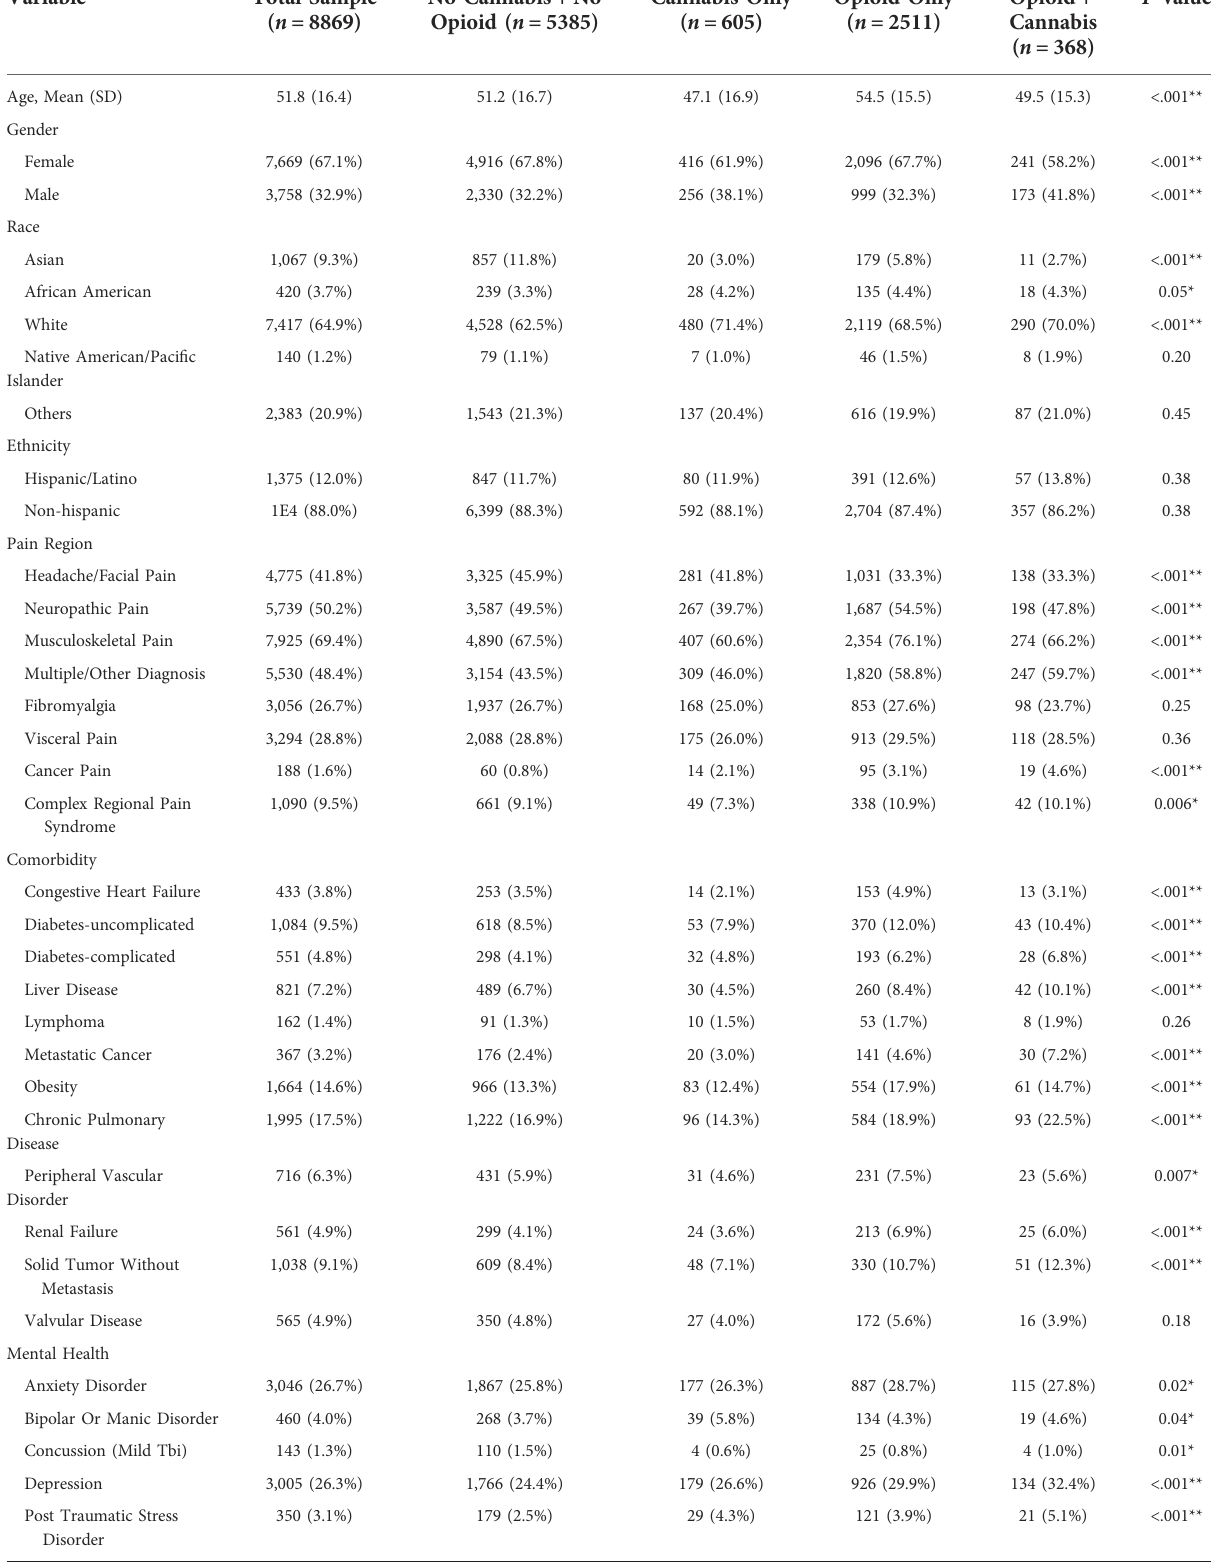
TABLE 1 Demographic and clinical characteristics of